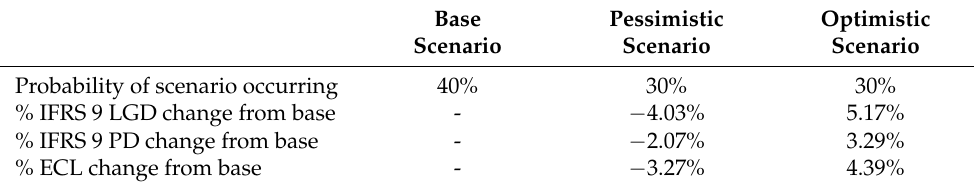
Table 4. Macro-economic adjusted IFRS 9 LGD values. Base Pessimistic Optimistic Scenario Scenario